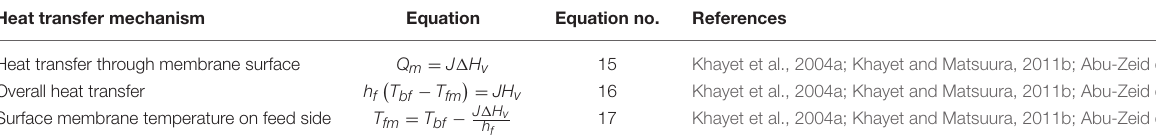
TABLE 3 | Heat transfer mechanisms for VMD at the membrane.